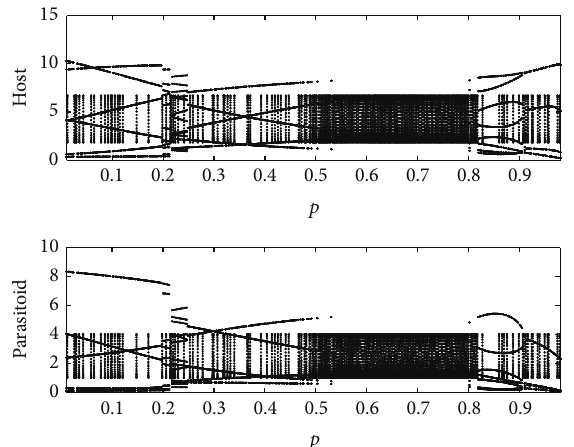
Figure 5: Bifurcation diagrams of model (3). For each 𝑝 the first 1101 simulated values are omitted to remove the initial transients and only the next 100 values are plotted. The host and parasitoid populations are plotted for 500 values of 𝑝 over [0.01, 0.99] . The other parameters are fixed as ET = 6.73 , 𝜏 = 2 , 𝛼 = 12 , 𝑏 = 1 , ,𝑃 ) = (3, 1) (𝐻 0 0